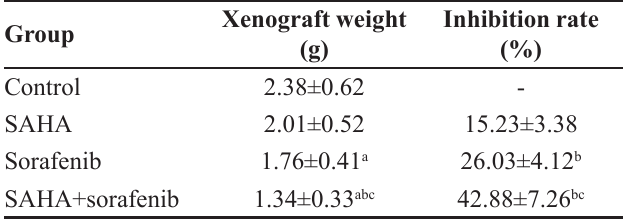
TABLE II - Growth of HCCLM3 xenograft in nude mice Group